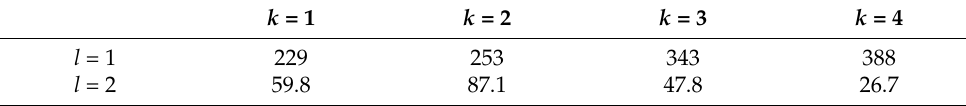
Table 9. Linear distance of DR